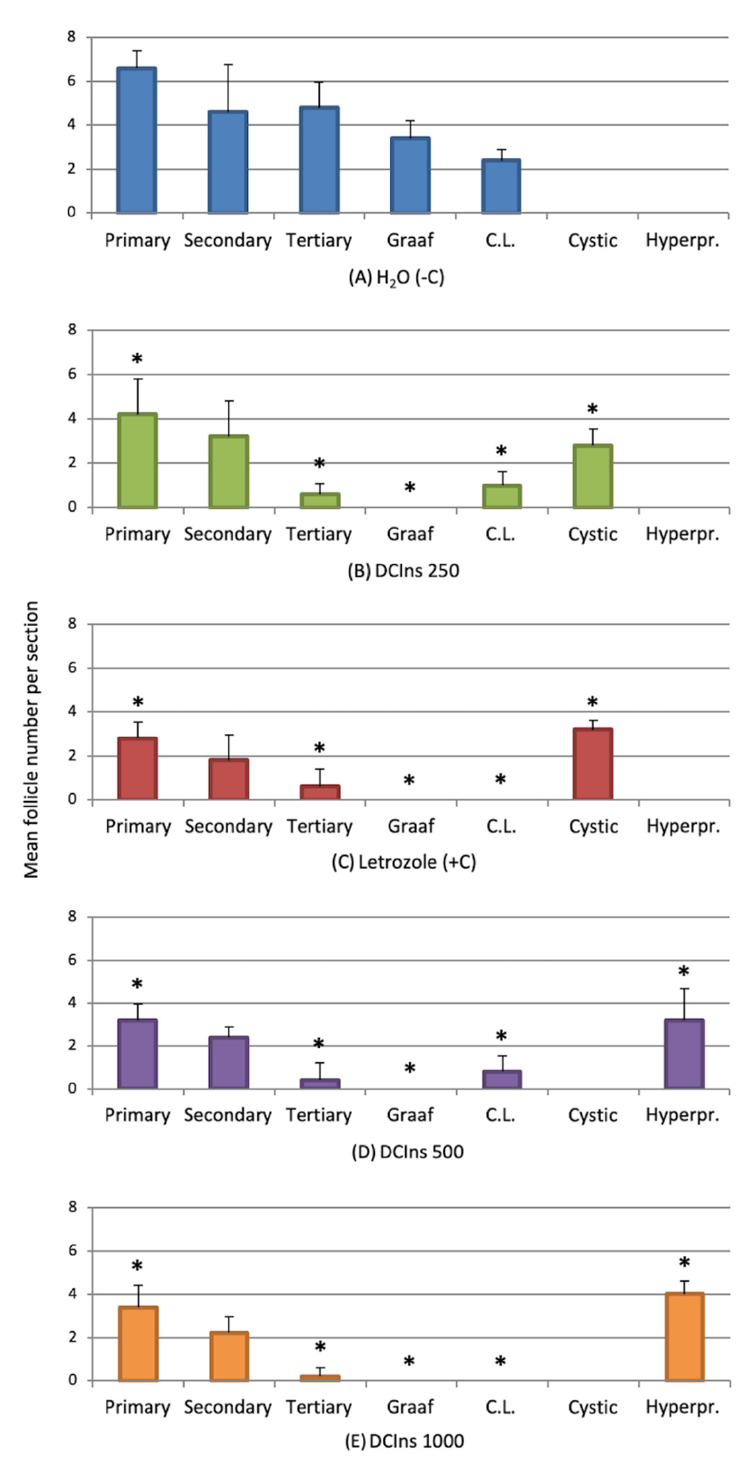
Figure 5. Number of ovarian follicles at different stages and of different types at the end of the treatment. Histograms represent numbers of follicle of various types in abscissa (mean ± SD). *, difference in group composition vs. negative control ovaries; p < 0.05, calculated by repeated measures ANOVA.